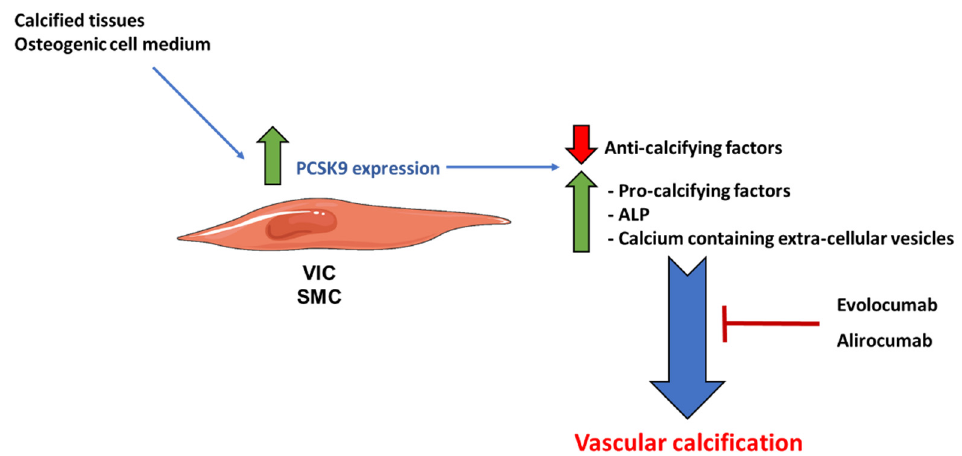
Figure 2. Role of PCSK9 in vascular calcification. PCSK9 expression is high in mouse and human calcified aortic valves, as well as in vitro VICs in the presence of pro-osteogenic medium. PCSK9 increases the number of secreted extracellular vesicles, containing more calcium and ALP, enhances the expression of pro-calcifying markers and lowers those of anti-calcifying mediators. These effects are blocked by evolocumab and alirocumab, two specific antibodies against PCSK9. ALP: alkaline phosphatase.